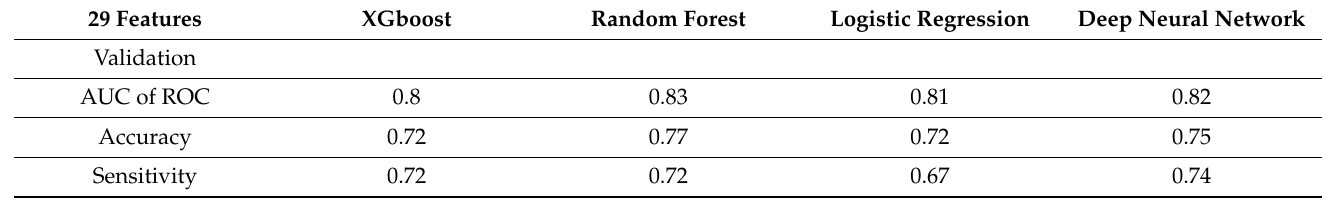
Table 2. The area under curve (AUC) of the receiver operating characteristic (ROC) curve, accuracy, sensitivity, specificity, positive predictive value (PPV), and negative predictive value (NPV) from different